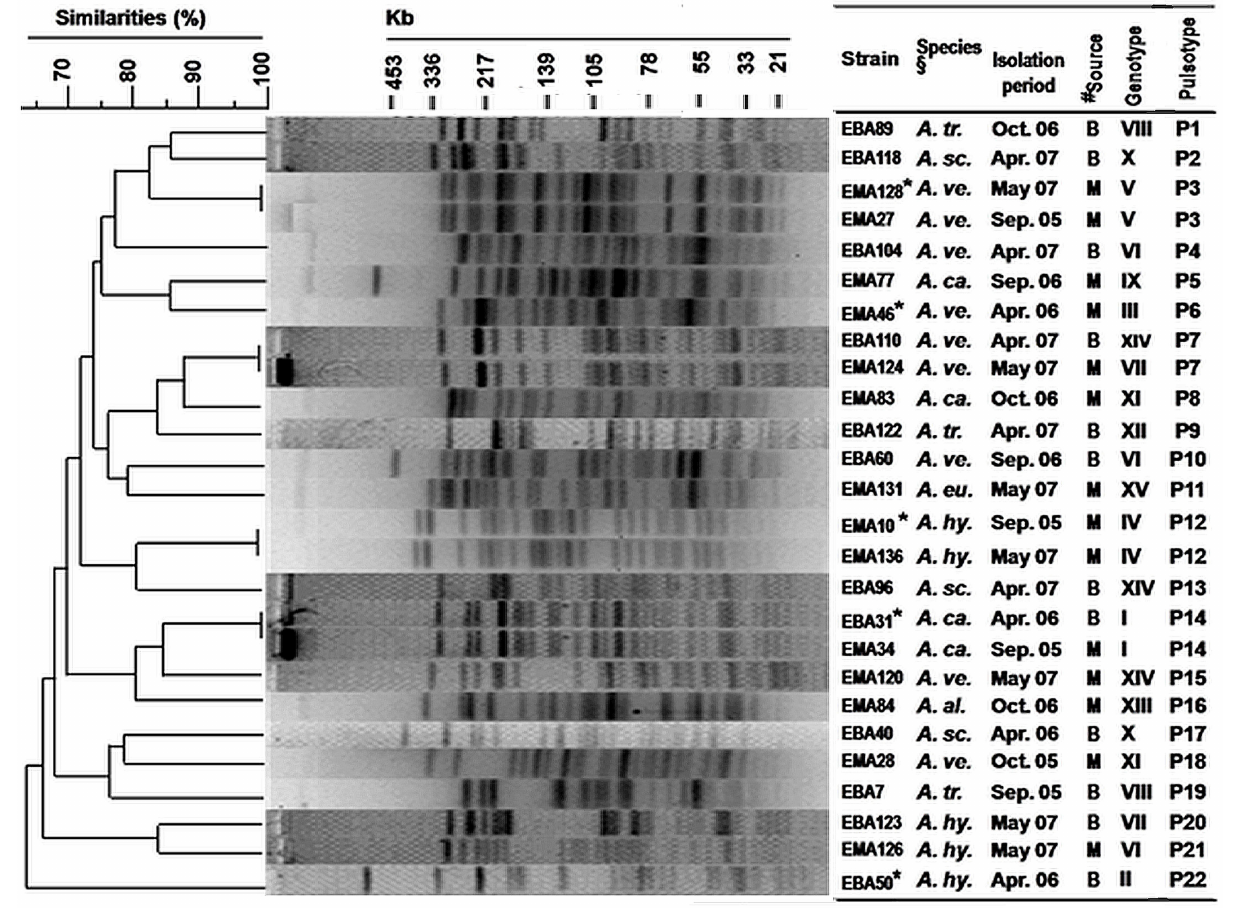
FIGURE 4 | Genetic diversity (by PFGE fingerprinting) among selected Aeromonas strains isolated from the pond waters in the coastal zone of Bangladesh. PFGE fingerprints were analyzed by using BioNumerics 4.0 software (Applied Maths Inc., TX, USA). Cluster analysis was done by the unweighted-pair group method using average (UPGMA) linkages and the band-based (Dice coefficient) option was applied. *Strains showing enterotoxigenic activities in rabbit ileal loop and suckling mice assays ( Supplementary Table 2 ). § Species names are abbreviated. # Isolation sources, “B” and “M” represented the coastal sites, “Bakergonj” and “Mathbaria”,